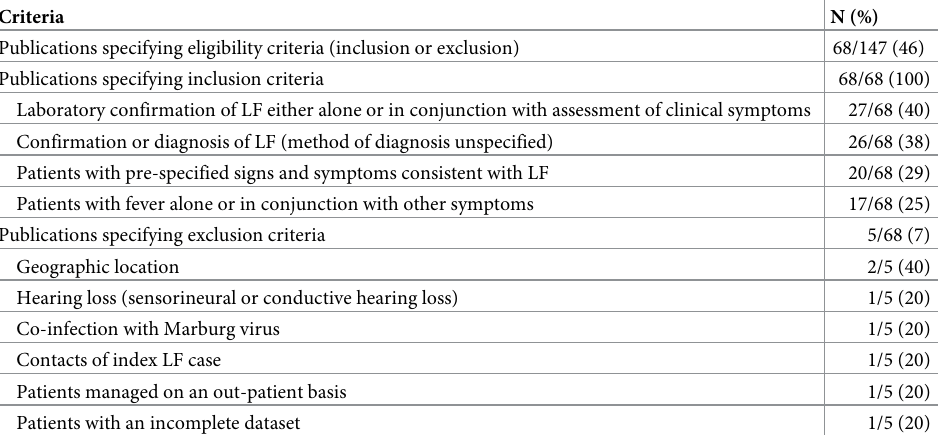
Table 3. Specified inclusion criteria by type (N = number of